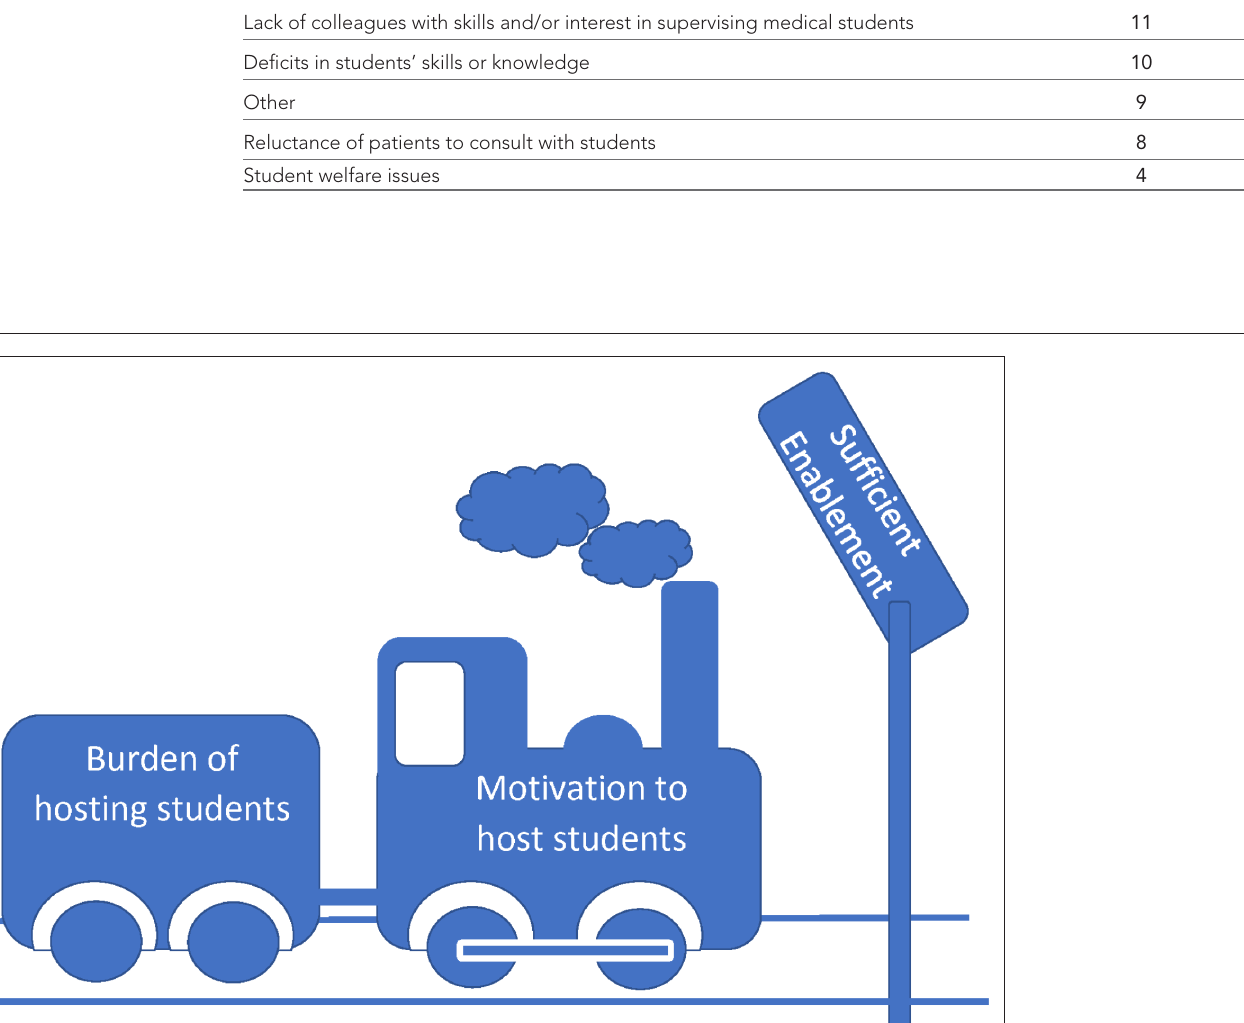
Darnton R et al . BJGP Open 2022; DOI: 10.3399/BJGPO.2022.0127